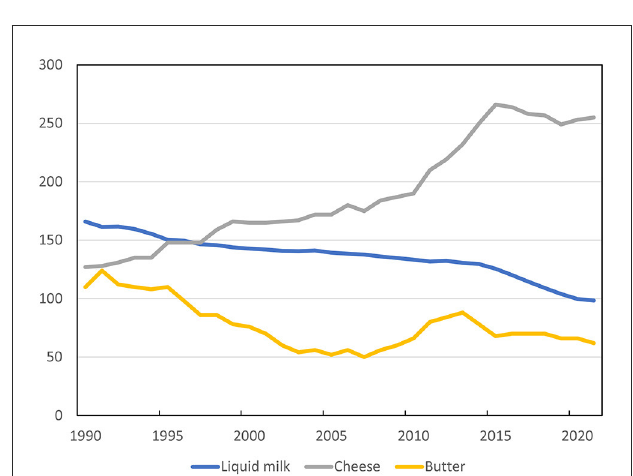
FIGURE2 Estimated consumption of milk products as liquid milk in Finland 1990–2021, kg/per capita. Source: Natural Resources Institute Finland (2022), Balance sheet for food commodities (2021 preliminary data). Fluid milk is a sum of whole milk, low-fat milk, and skim milk consumption. The estimated amount of liquid milk used for 1kg of cheese is about 10kg of liquid milk. The estimated amount of liquid milk used for 1kg of butter is about 20kg of liquid milk. Sources: for cheese, Dairy Food Safety (2022) and for butter, Oldenburger Professional